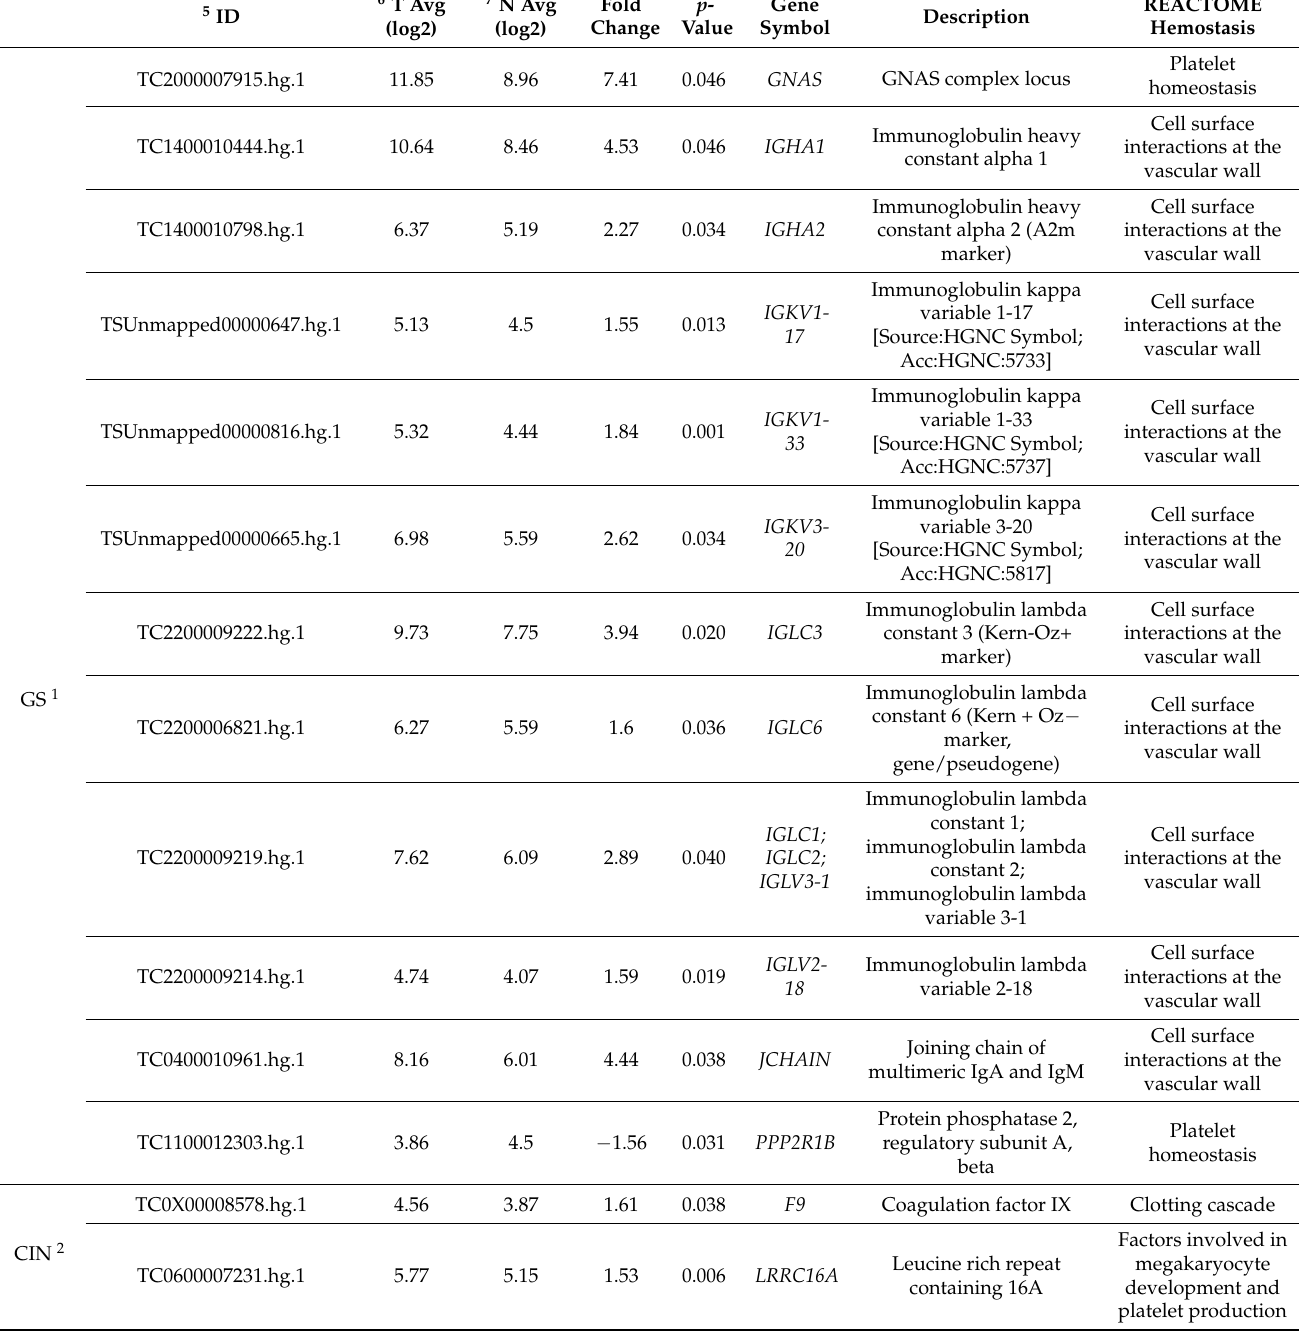
Table 5. Within each TCGA category, differentially expressed genes between patients with venous thromboembolism and controls that were associated to hemostatic pathways according to REAC- TOME software. Fold change quantifies differences in gene expression when comparing thrombotic patients respecting to controls. p -value indicates significance grade of gene expression differences between thrombotic cases and controls. Column on the right shows specific pathways related to hemostasis to which genes are associated, according to REACTOME